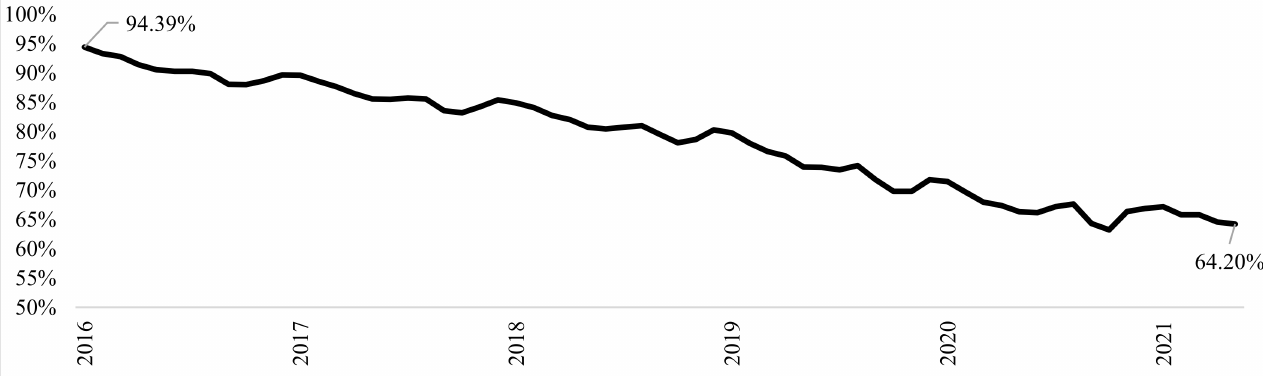
Figure 3. PPC’s Market Share (%), (2016–May 2021), Source: Hellenic Energy Exchange and Authors’ estimations.